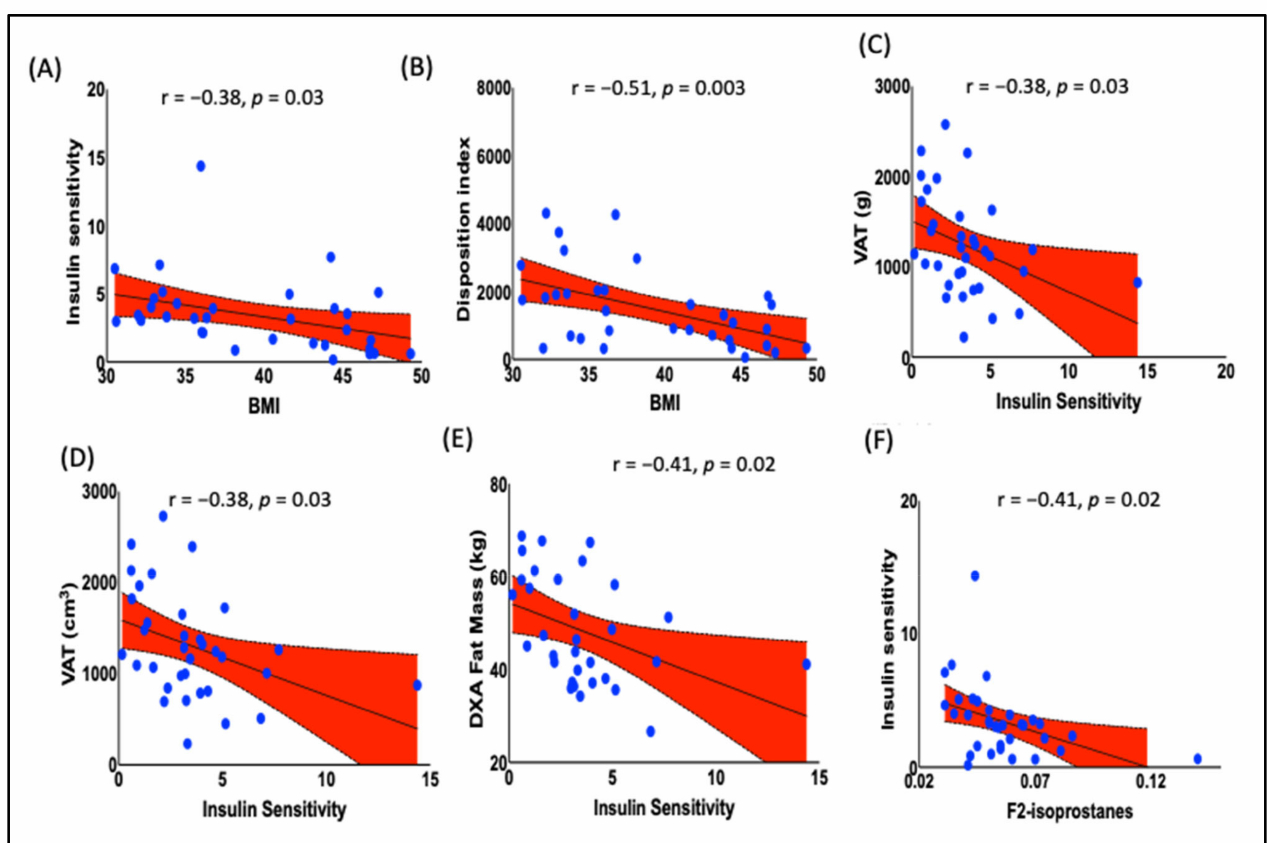
Figure 5. Relationship of prediabetic indices with BMI and other anthropometrics. BMI was inversely correlated with prediabetic indices ( A ) insulin sensitivity (r = − 0.3753, p = 0.0287) and ( B ) disposition index (r = − 0.51, p = 0.003). Moreover, ( C ) e-VAT (g, r = − 0.38, p = 0.03), ( D ) e-VAT (cm 3 , r = − 0.38, p = 0.03), ( E ) DXA fat mass (r = − 0.41, p = 0.02), and ( F ) F 2 -IsoPs (r = − 0.41, p = 0.02) levels were inversely correlated with insulin sensitivity. Pearson’s correlation analysis was employed to determine the correlation. p < 0.05 was considered a statistically significant correlation. BMI, body mass index; e-VAT, estimated visceral adipose